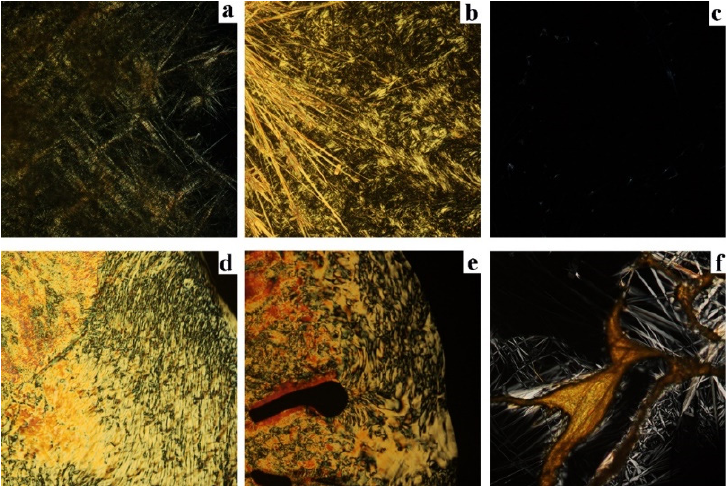
Figure 4. Representative POM textures of the C4-Azo-C5-HDA, under different temperature ( a ) gelator obtained from hydrogel, room temperature; ( b ) 144 °C, crystal-smectic transition; ( c ) 160 °C, isotropic phase; ( d ) cooled from isotropic liquid, 130 °C, nematic phase; ( e ) 126 °C, nematic-smectic transition; ( f ) 122 °C, smectic-crystal transition. 100× magnification.